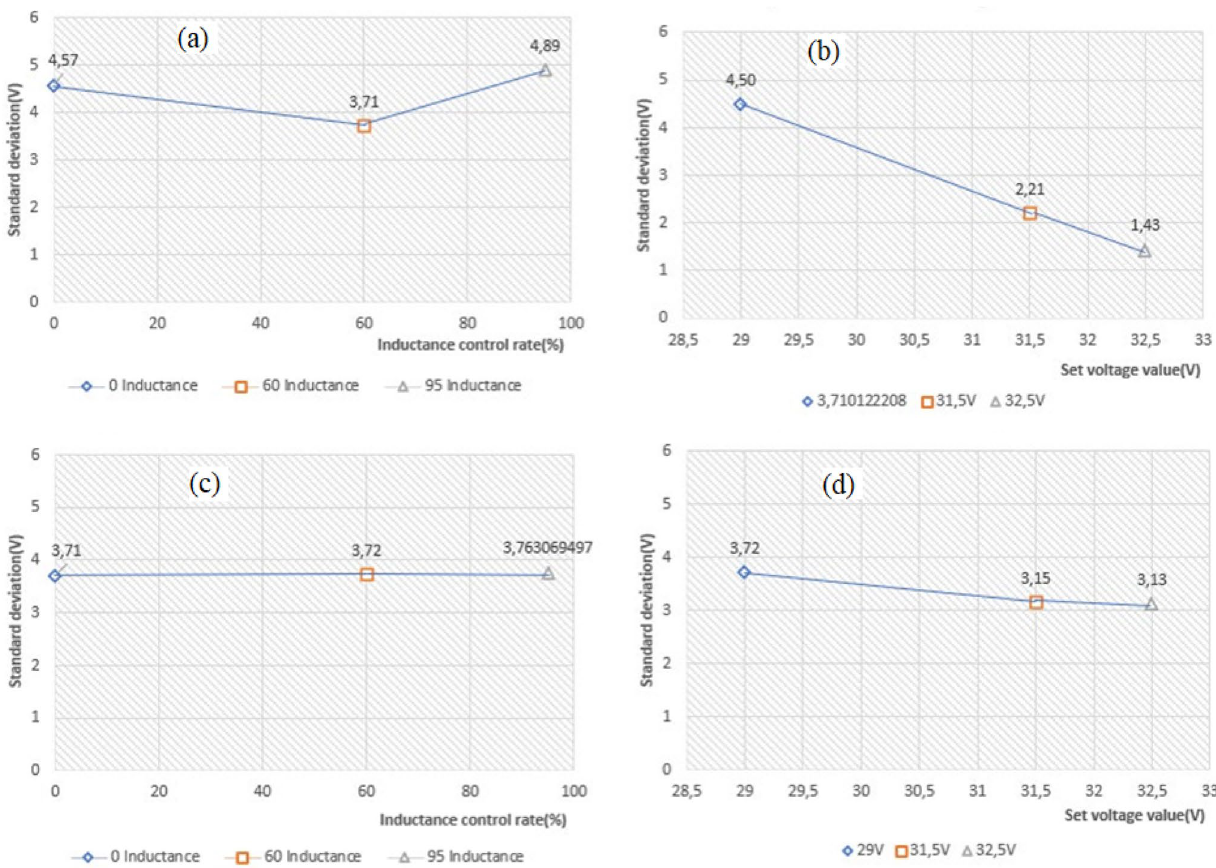
peaks vs set voltage value; c : standard deviation of positive voltage peaks vs inductance control rate; d standard deviation of positive voltage